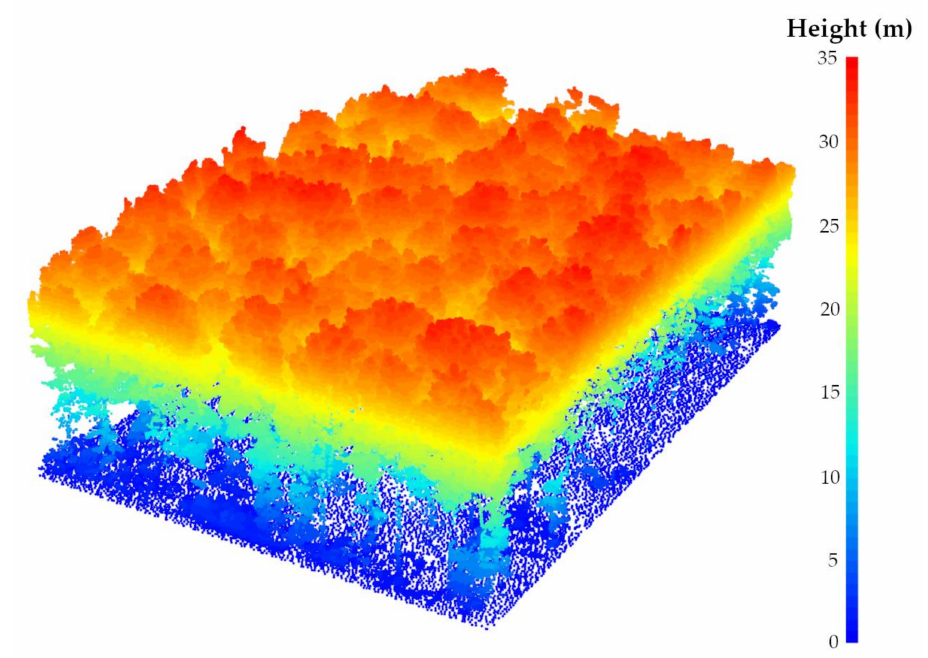
Figure 4. Normalized dataset (leaf-on season and 12 ◦ MSAR) using a point-based approach and the spatial TIN interpola- tion